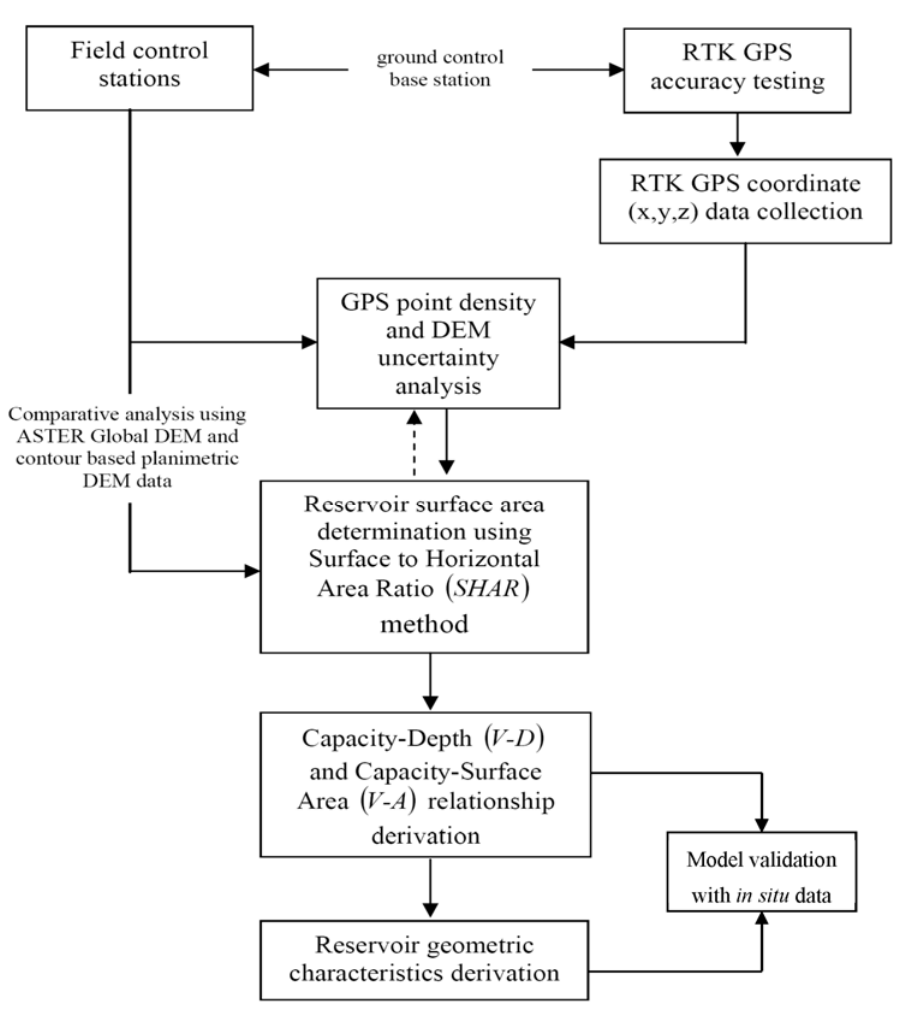
Figure 3. Schematic approach for the reservoir geometric parameters estimation and reservoir power curve model equation development.